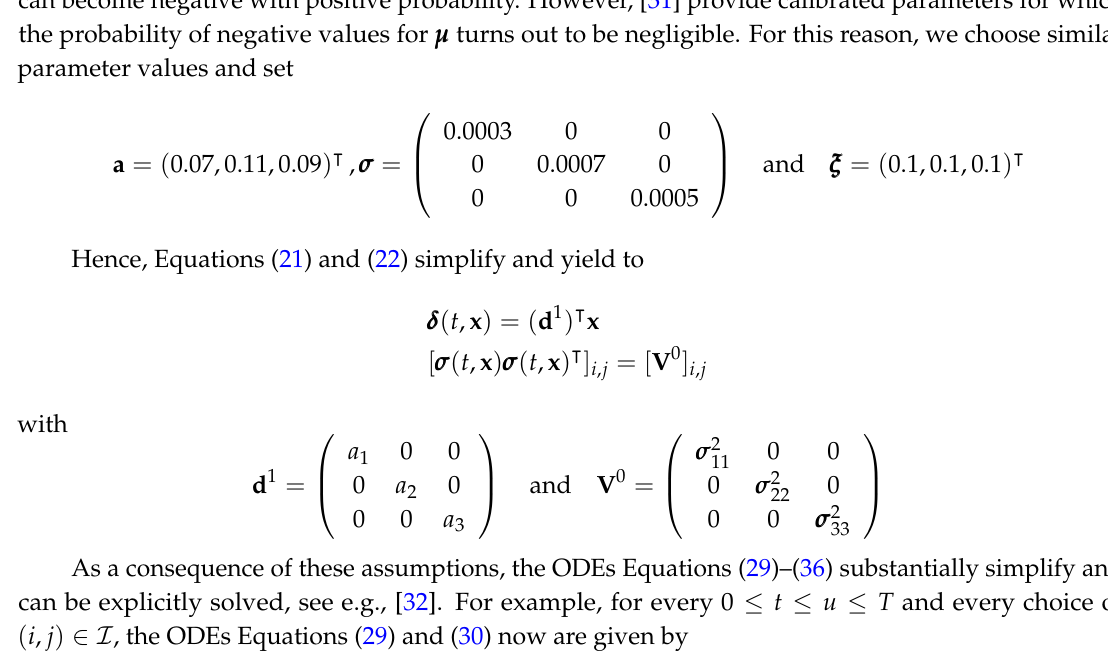
with absorbing state 3. }